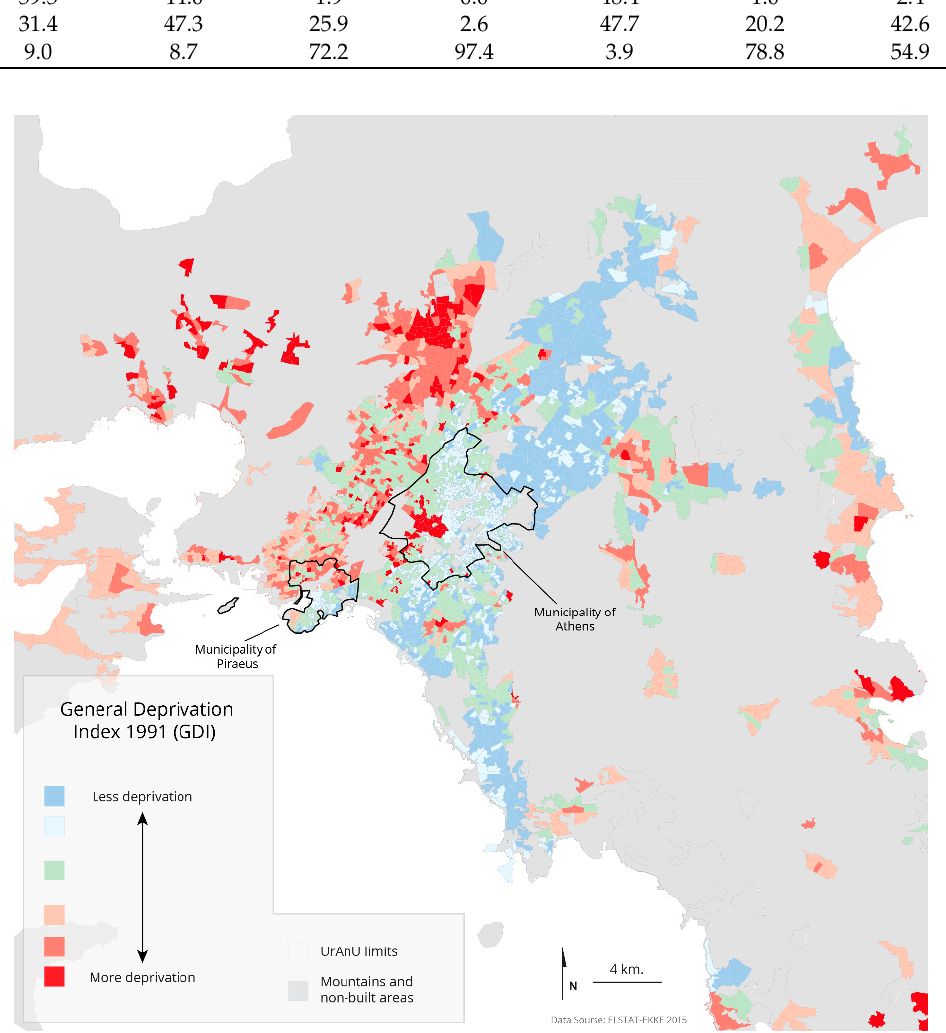
Figure 3. Clusters of deprivation in Athens (1991).